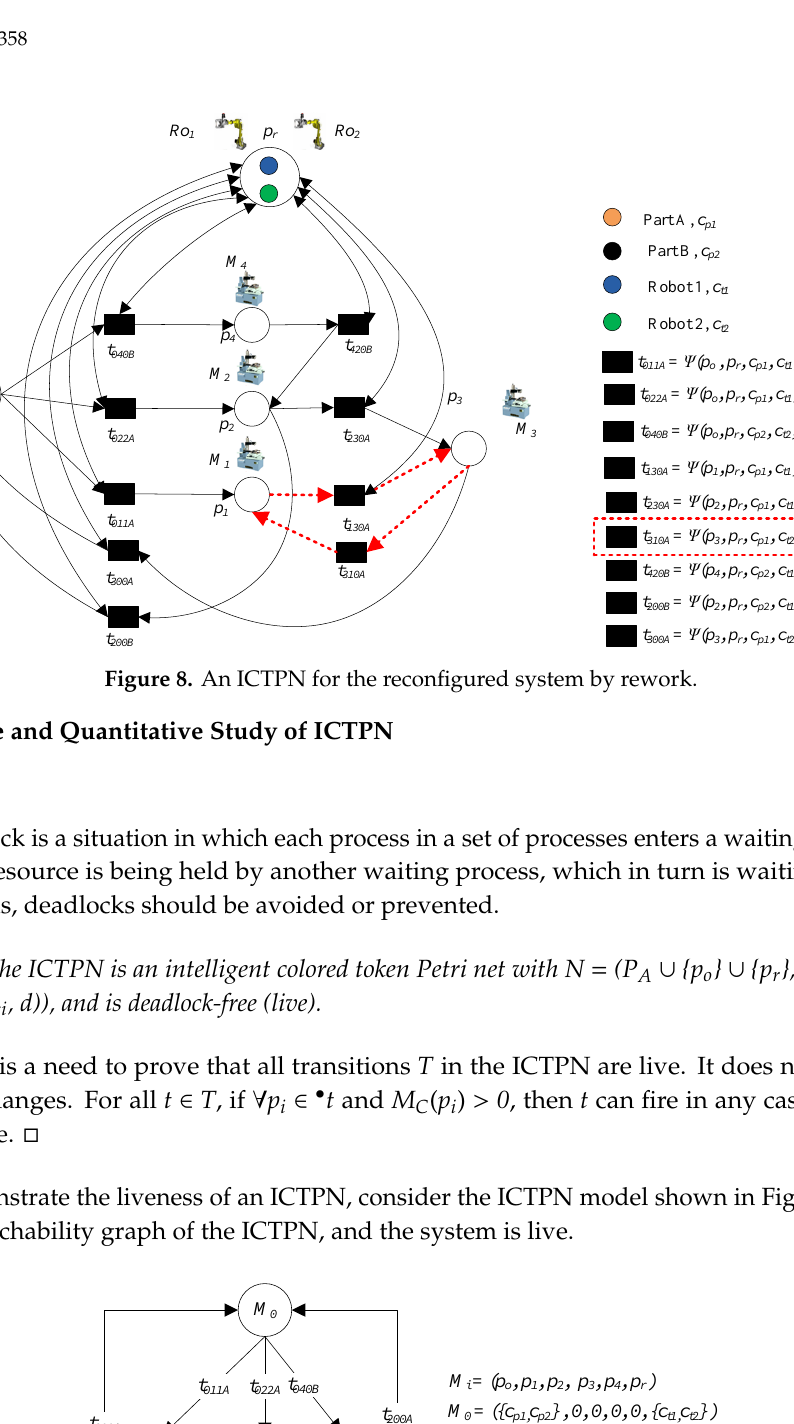
Figure 9. Reachable marking of an ICTPN example, as shown in Figure 2.